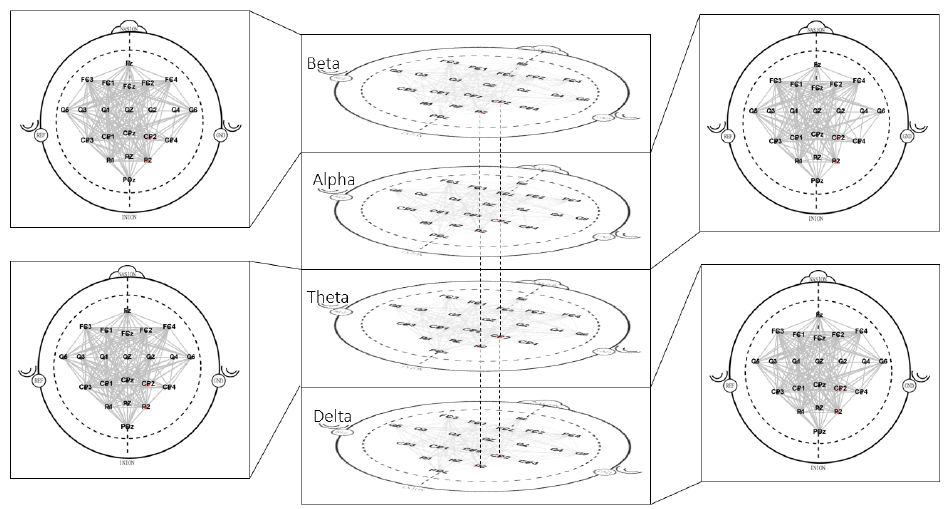
Figure 12. Multilayer graph for right-hand movement intention. Each electrophysiological band is a layer of the graph. Those electrodes with significative difference identified (CP2 and P2) are highlighted in red in the present study. Cross-layer edges are found for all nodes, yet only those corresponding to the significant electrodes are plotted. Each individual layer is shown separately to provide a more detailed picture of the intra-layer